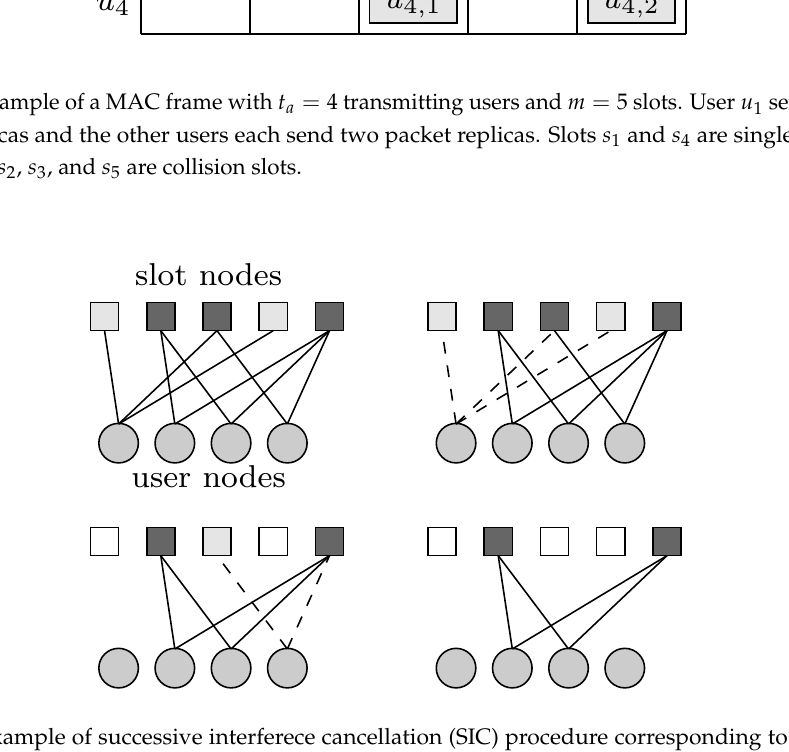
Figure 2. Example of successive interferece cancellation (SIC) procedure corresponding to Figure 1. Squares correspond to slots and circles correspond to users.